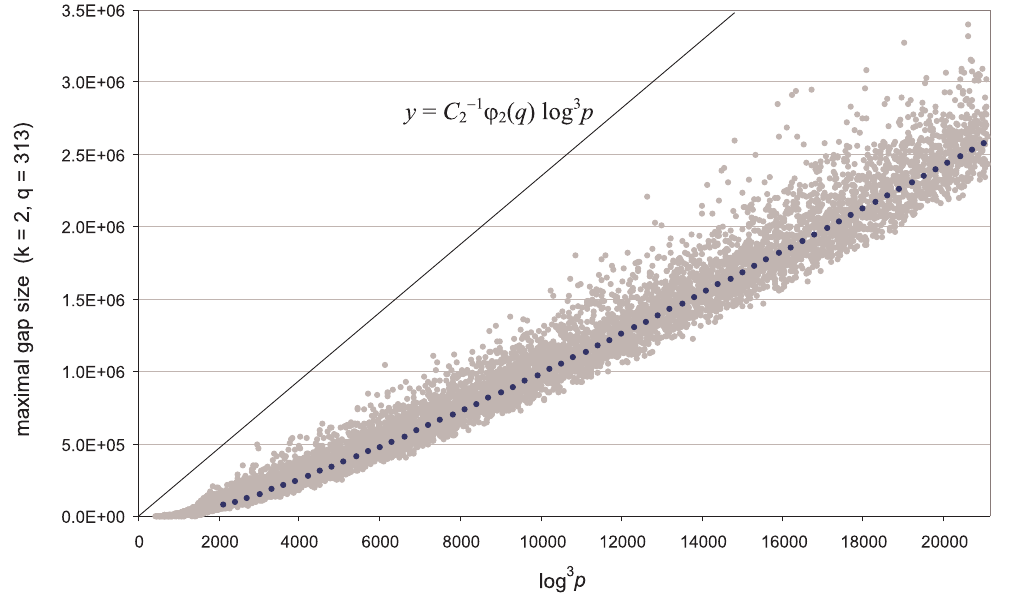
Figure 2. Maximal gaps G c between lesser twin primes p = r + nq ∈ P c below x for q = 313, x < 10 12 , k = 2. Dotted curve: trend T c of Equation(12); top line: y = C − 1